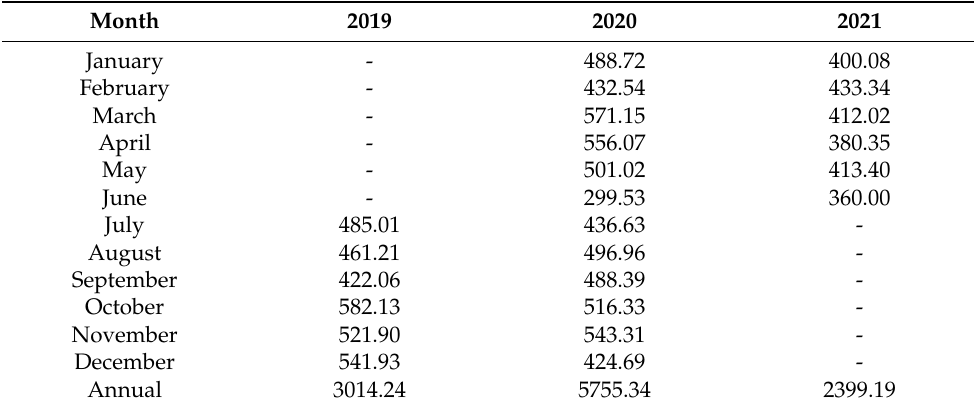
Table 4. Monthly Energy Generation of the Carport (kWh).